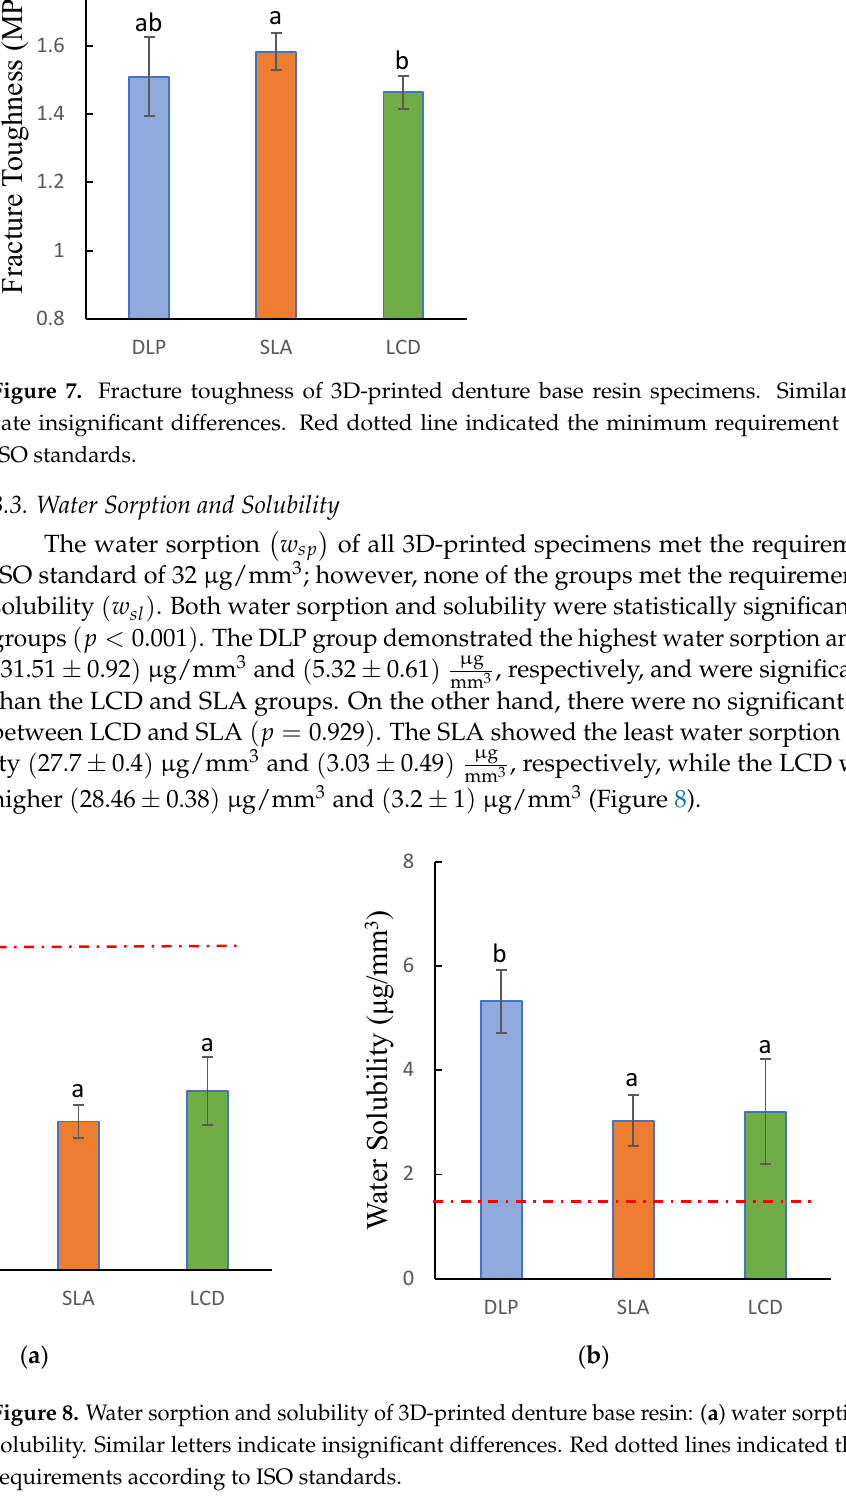
Figure 9. Adherence of Candida Albicans on 3D-printed denture base resin specimens. Similar let- ters indicate insignificant differences. 4. Discussion This present study elucidated the printability and characterization of the 3D-printed denture base resin material fabricated by 3D printing with different vat polymerization techniques. Stereolithography (SLA), digital light processing (DLP), and liquid-crystal display (LCD) is the most practice technique in vat polymerization to fabricate dentures. Although these techniques work under the same principle of photo-polymerization, their imaging system differs from each other and might result in different printing outcome. Moreover, the commercially available 3D printing resins were only designed for a partic- ular printing technique. For instance, the NextDent Denture 3D+ is a 3D printing denture resin material that is a part of the NextDent close system that only allows printing with its own proprietary printer. This study elucidated that the flexural strength, fracture toughness, water sorption and solubility, and fungal adhesion deviated when the denture base material was fabricated with different vat polymerization techniques. Henceforth, the null hypothesis of this study was rejected.